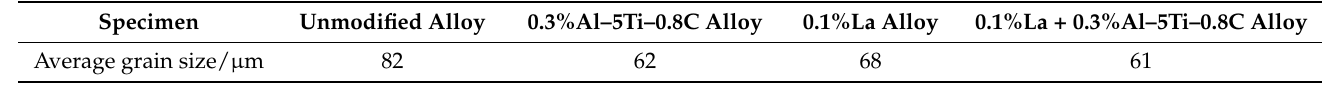
Table 2. Grain size of ZL205A alloy with the addition of Al–5Ti–0.8C and La. Specimen Unmodified